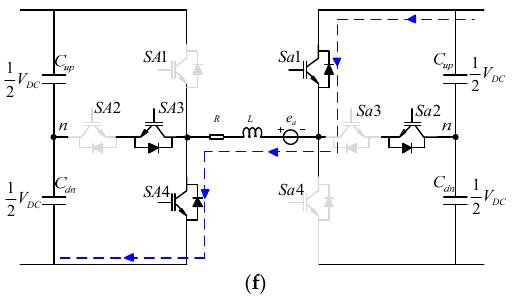
Figure 7. Current loop in different current loop. ( a ) (SA, Sa) = (4,2); ( b ) (SA, Sa) = (4,3); ( c ) (SA, Sa) = (3,2); ( d ) (SA, Sa) = (3,4); ( e ) (SA, Sa) = (2,3); ( f ) (SA, Sa) =